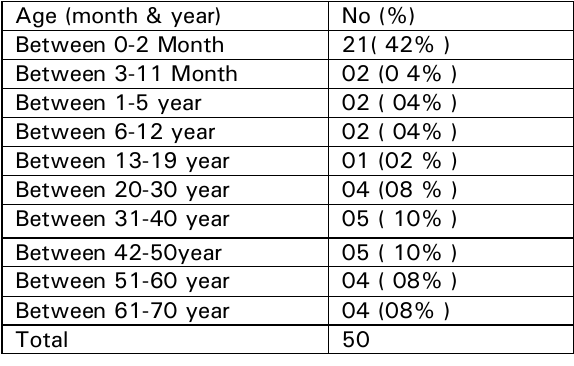
Table 3: Age, sex-wise and species-wise distribution of C.species